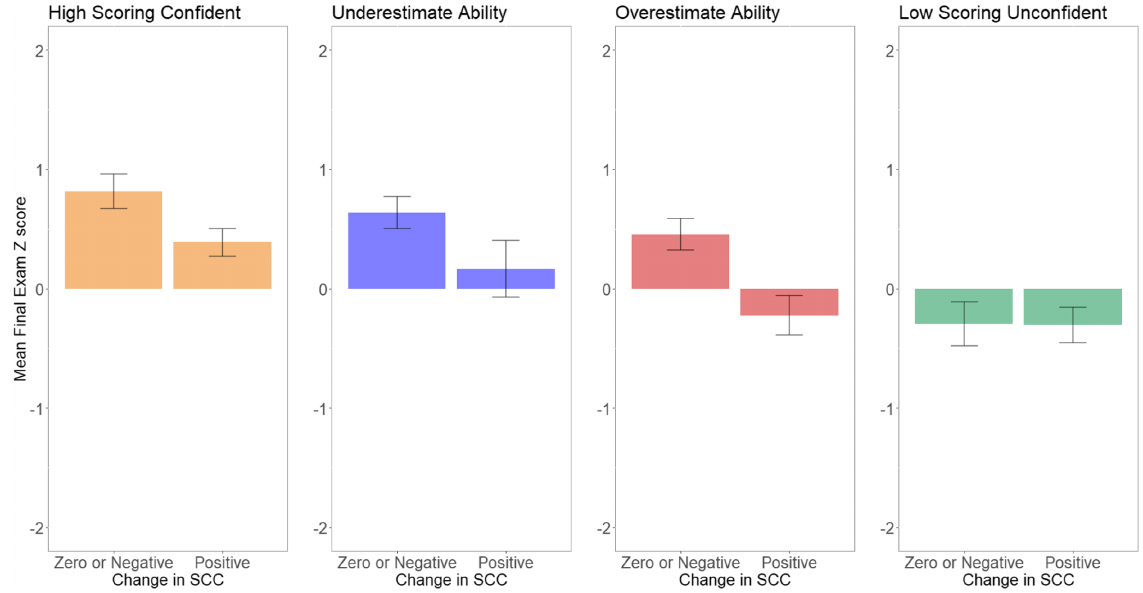
FIG. 7. Mean final exam z score vs the change in SCC and initial-state group. Error bars represent 1